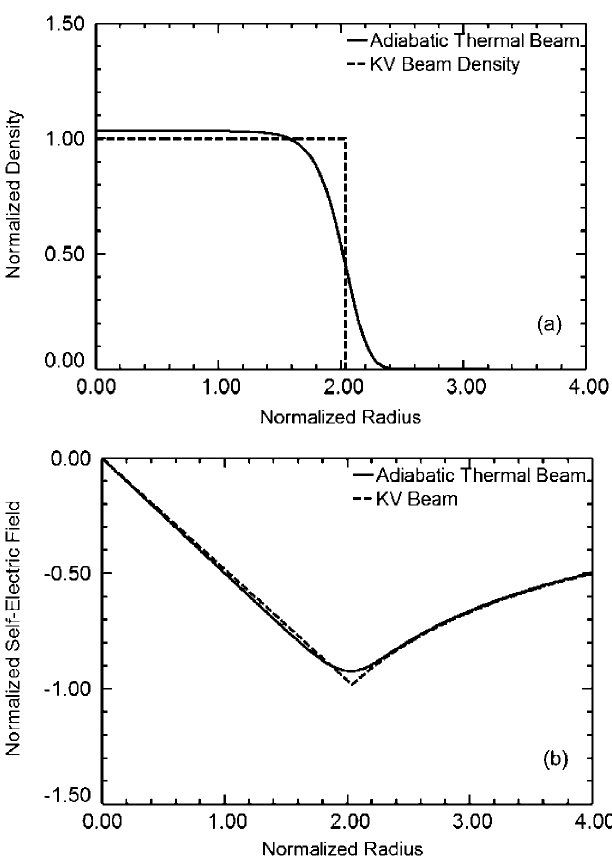
FIG. 3. Poincare´ surface-of-section maps of charged-particle trajectories in (a) KV-type beam equilibrium and (b) adiabatic thermal beam equilibrium for P (cid:9) ¼ 0 and the same choice of system parameters as in Fig. 1. Here, the normalized radial momentum is ð S= 4 " th Þ 1 = 2 dr=ds and the normalized radius is p ffiffiffiffiffiffiffiffiffiffiffiffi S r= 4 " th